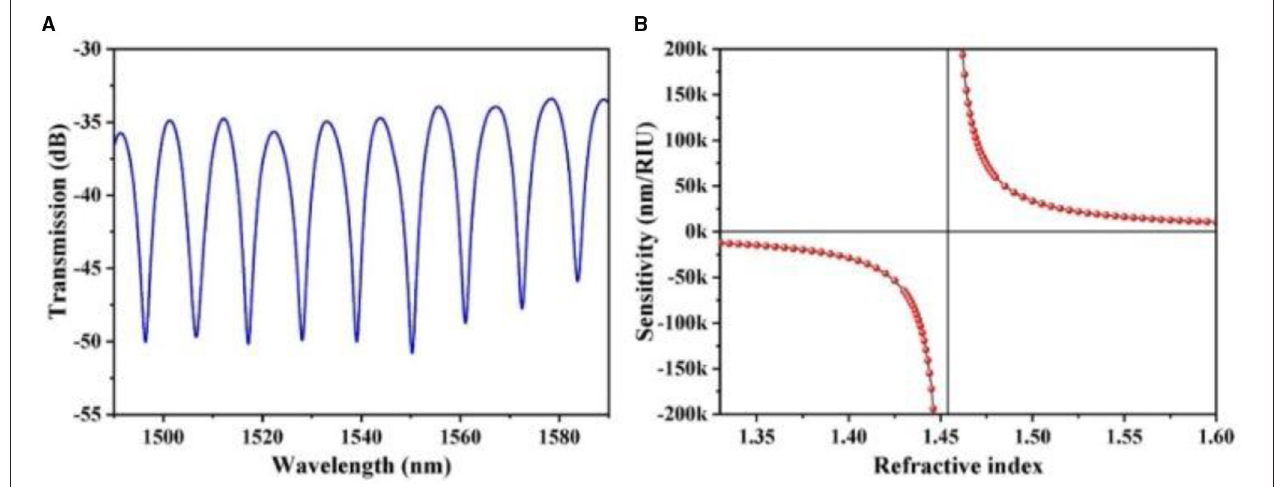
FIGURE 4 | (A,B) Transmission spectra and sensitivity calculation of Machzehnder Interferometer (12).